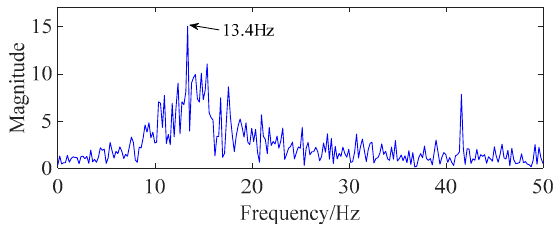
Figure 14. Feature-frequency extraction of overload-current fault.